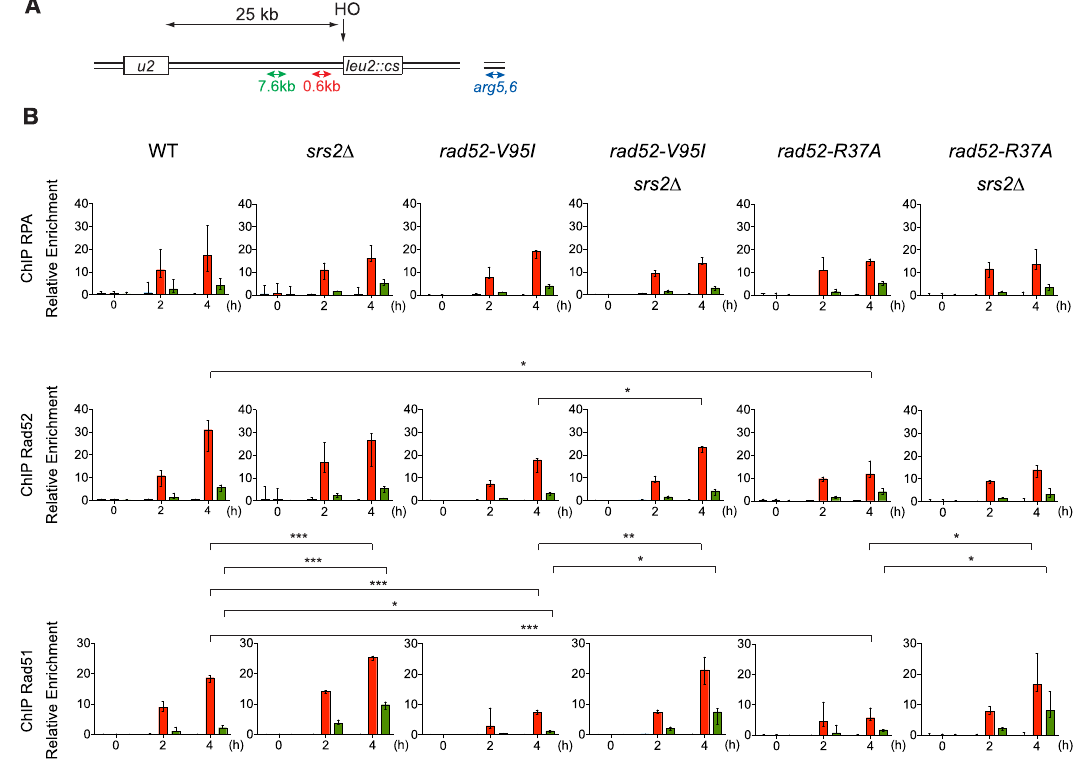
Figure 8. ChIP analysis of Rad51 filament formation at a DSB created by the HO endonuclease. ( A ) Schematic of the HO-induced SSA repair system. The used primers are shown. ( B ) ChIP was used to assess RPA, Rad52 and Rad51 relative enrichment at 0.6 kb (red) and 7.6 kb (green) from the DSB site and at the uncut ARG5,6 locus (blue) at the indicated time points (hours) after HO induction. The median value (n = 3 or 4) is shown and error bars represent the upper and lower values; * p < 0.05, ** p < 0.01, *** p < 0.001 (unpaired t -test for the value at 4 h after HO-induction; only significant differences are shown). In rad52-V95I-FLAG cells, RPA loading was not significantly changed, compared with RAD52-FLAG cells. Conversely, Rad51 loading at 0.6 kb was reduced by 2.5-fold. This could be interpreted as a deficiency of Rad52 mediator activity. However, in rad52- V95I -FLAG srs2∆ cells, Rad51 loading was 2.8- and 5.5-fold higher than in rad52-V95I- FLAG cells at 0.6kb and 7.7 kb respectively, as observed in srs2∆ cells. Therefore, the re- duction in Rad51 loading in rad52-V95I-FLAG cells fully depends on Srs2 activity. We previously obtained similar results with Rad52 mutants that impair Rad52–Rad51 inter- action [26]. Rad52-V95I-FLAG recruitment also decreased by 1.7-fold compared with WT, and was significantly increased 1.3-fold in Srs2-deficient cells. Altogether, these results suggested that the Rad52 N-terminal domain integrity is essential to prevent Rad51 and Rad52 disassembly by Srs2. We also performed the same experiment in rad52-R37A cells. Surprisingly, we ob- served a 3.3-fold decrease in Rad51 recruitment at 0.6 kb, which was Srs2-dependent be- cause Rad51 loading was increased by 2.9-fold in Srs2-deficient cells at this locus. Rad52- R37A-FLAG loading was reduced by 2.6-fold compared with WT. Besides the defect in ssDNA pairing and SSA, Rad52-R37A is also defective for Rad51 filament protection. As rad52-V95I impairs only Rad51 protection, we concluded that the Rad51 filament protec- tion function can be separated from the ssDNA pairing activity.